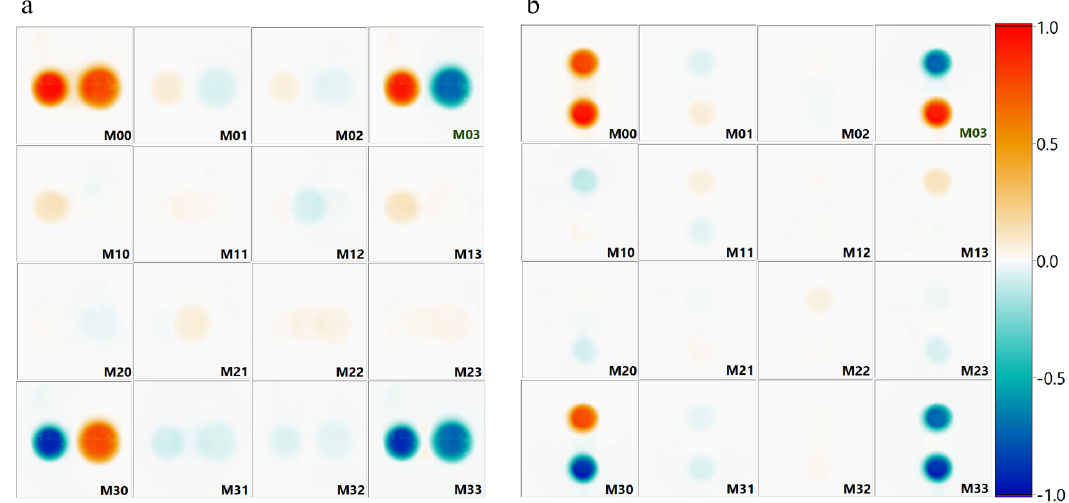
Figure 6. Unnormalized Mueller matrix images (diffractometer mode) for the lens ( a ) and the grating ( b